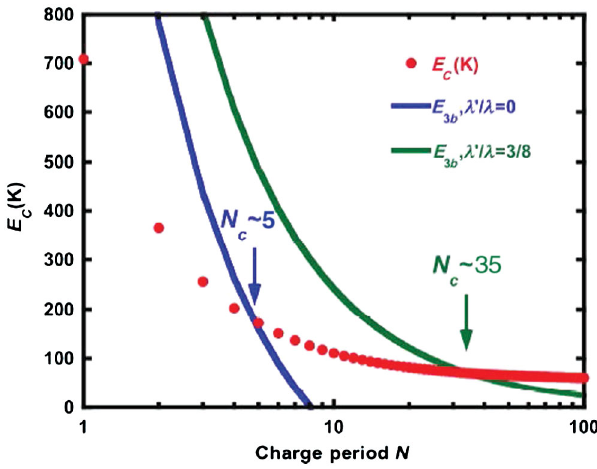
FIG. 2. Values of the Coulomb energy, E C , and the absolute values of the negative elastic energies, E 3 b , have been averaged over the Mn sites along an ODW as a function of the charge period, N . The critical value of N , that occurs when these energies compensate, is N c and it is shown for theoretically allowed extremal values of λ 0 = λ ¼ 0 and 3 = 8